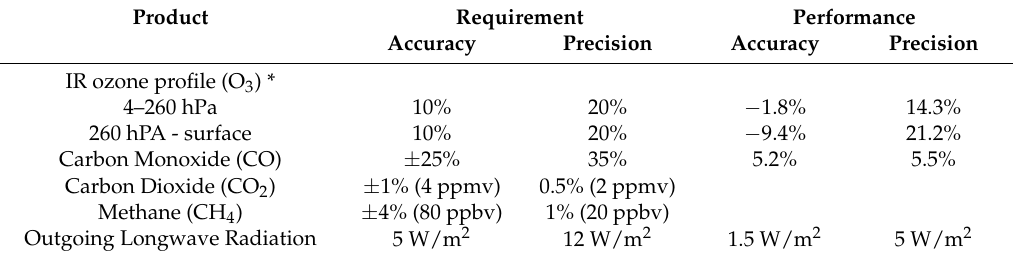
Table 11. S-NPP NUCAPS trace gases and OLR products performance.